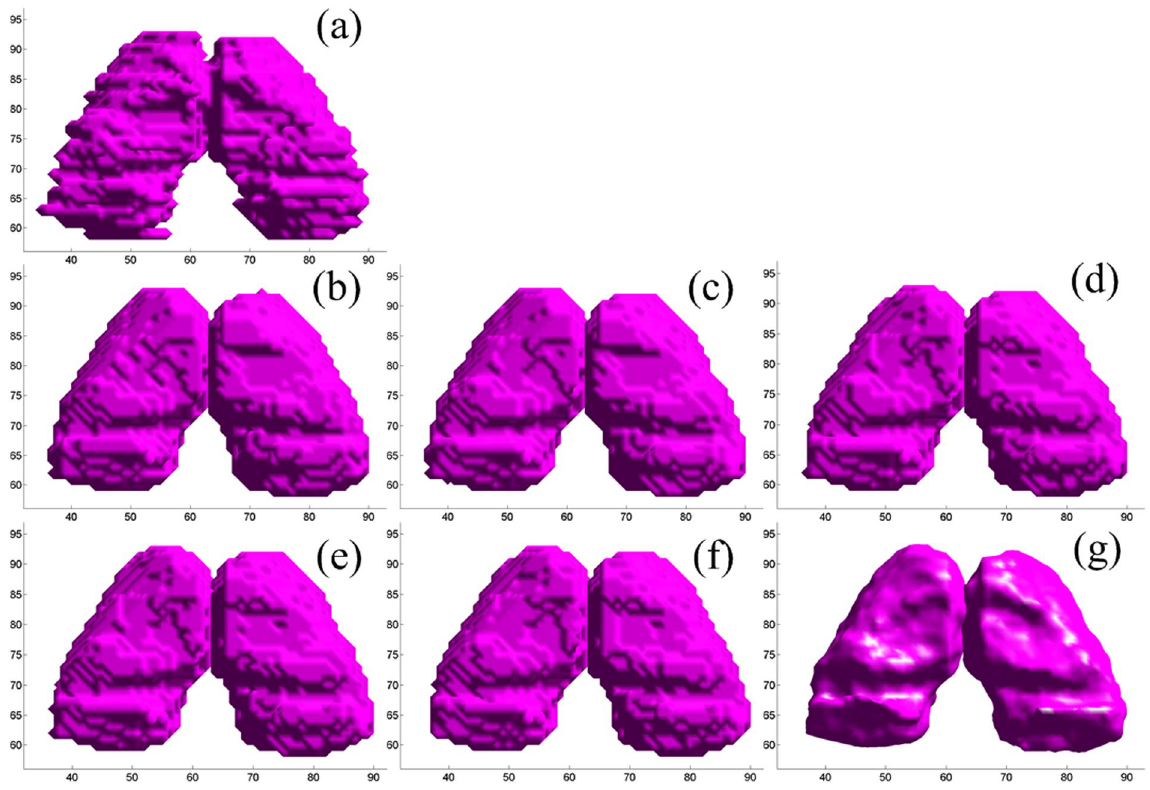
Figure 9. Surface rendering of ground truth and segmentation results (MICCAI, image No. 1006). ( a ) The manual segmentation, ( b ) STAPLE, ( c ) Spatial STAPLE, ( d ) Major Voting, ( e ) Weight Voting, ( f ) SIMPLE and ( g ) our proposed